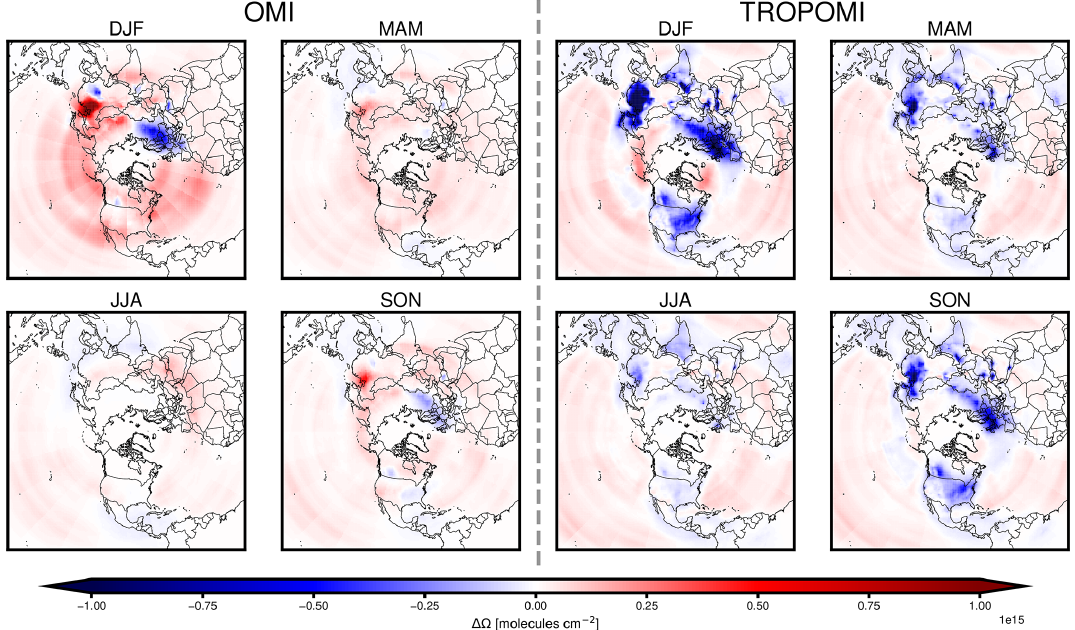
Figure 4. Seasonal NO 2 VCD change ( (cid:49)(cid:127) ) from CMAQ simulation using prior emissions after assimilating OMI or TROPOMI tropospheric NO 2 observations and modeling atmospheric composition with prior NO x emissions. (cid:49)(cid:127) shown for winter (DJF), spring (MAM), summer (JJA), and fall